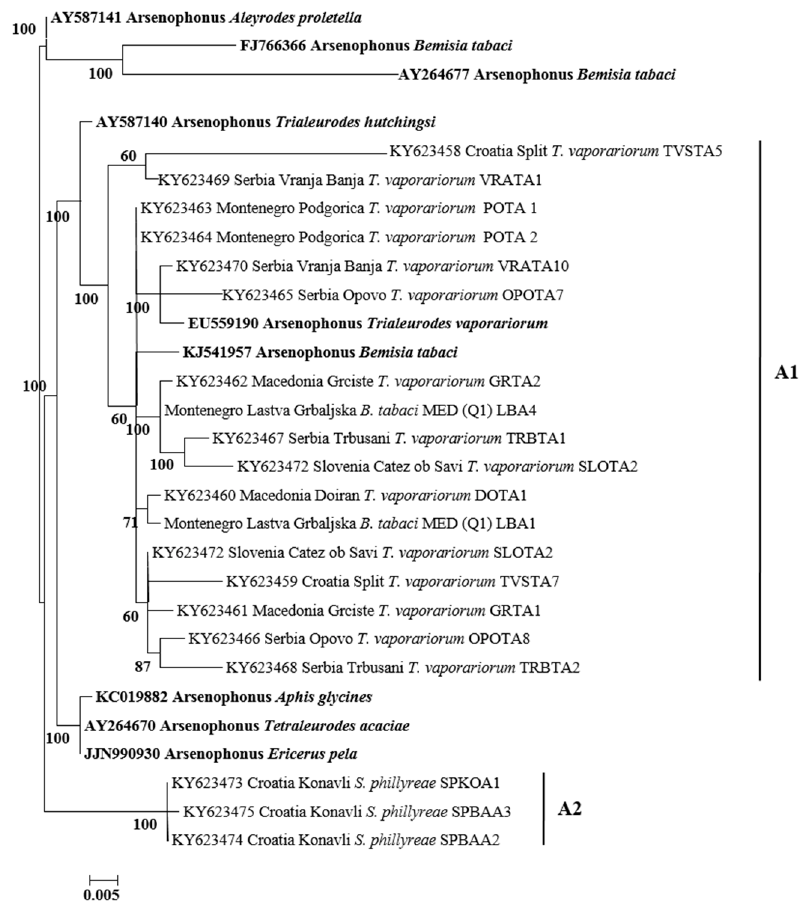
Figure 4. Molecular phylogenetic placements of Arsenophonus from whitefly species. The tree was constructed via Bayesian inference (BI) using a TPM1 μ f substitution model. Sequences from GenBank are indicated in bold, while those obtained in this study are rearranged based on geographical origin and associated whitefly hosts, B. tabaci , T. vaporariorum , and S. phillyreae .